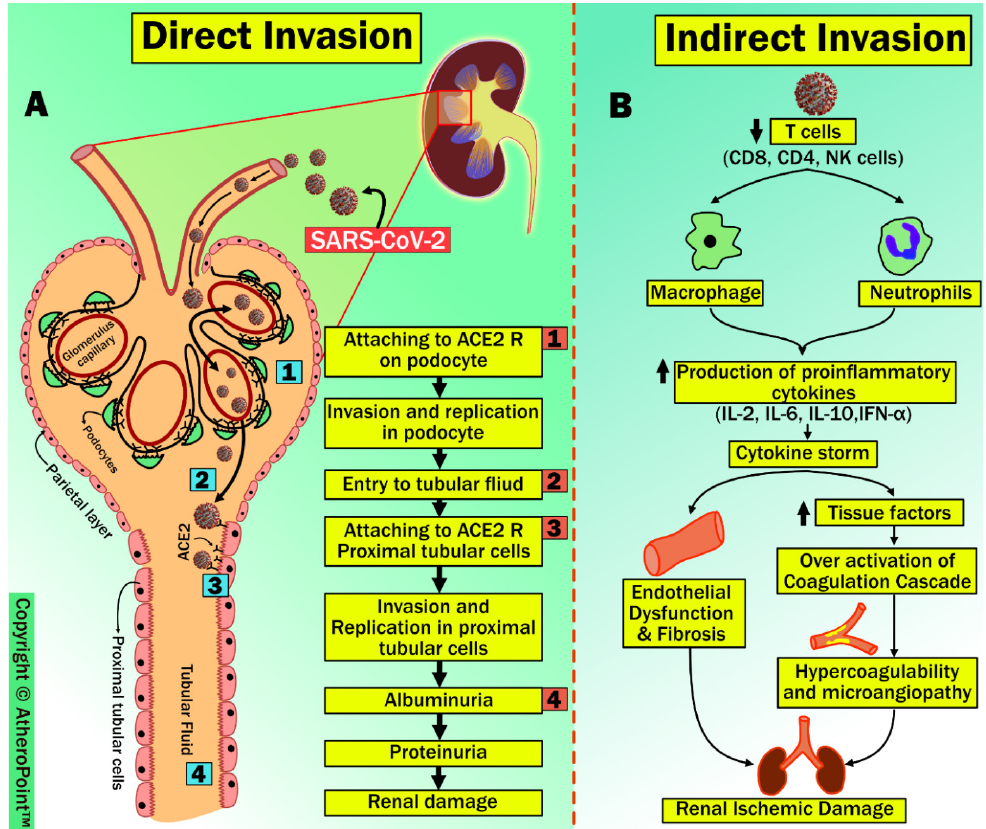
Figure 7. Renal vascular damage due to COVID ‐ 19 through direct and indirect invasion. (Original